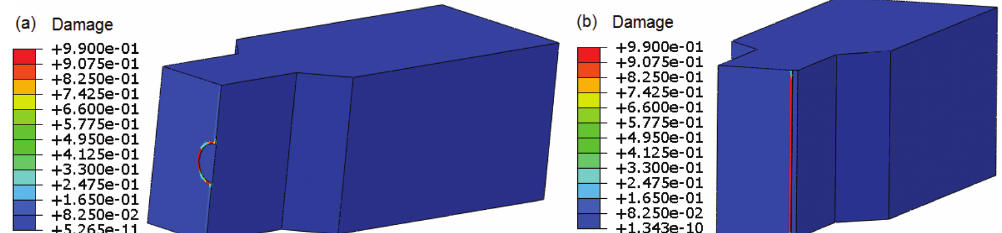
Figure 5: The creep damage distribution for semicircular (a) and straight (b) defects.